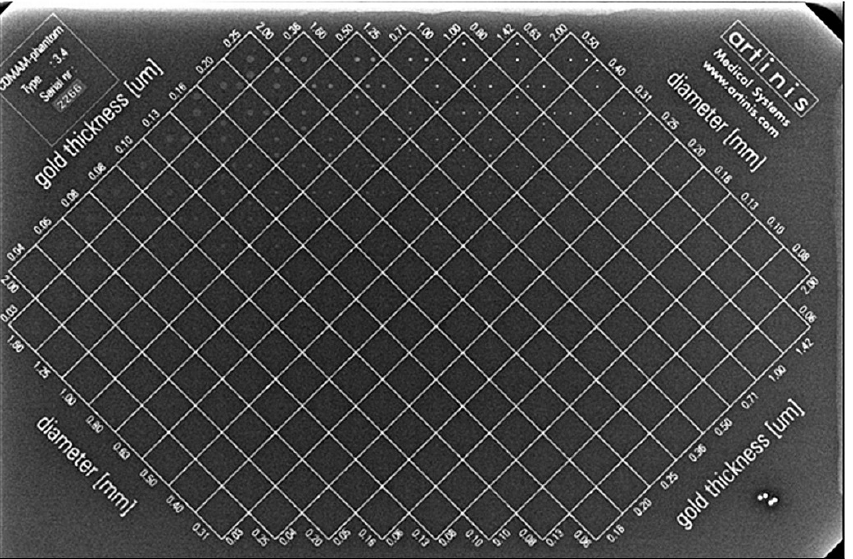
Figure 1. Radiographic appearance of the CDMAM phantom used in this study.